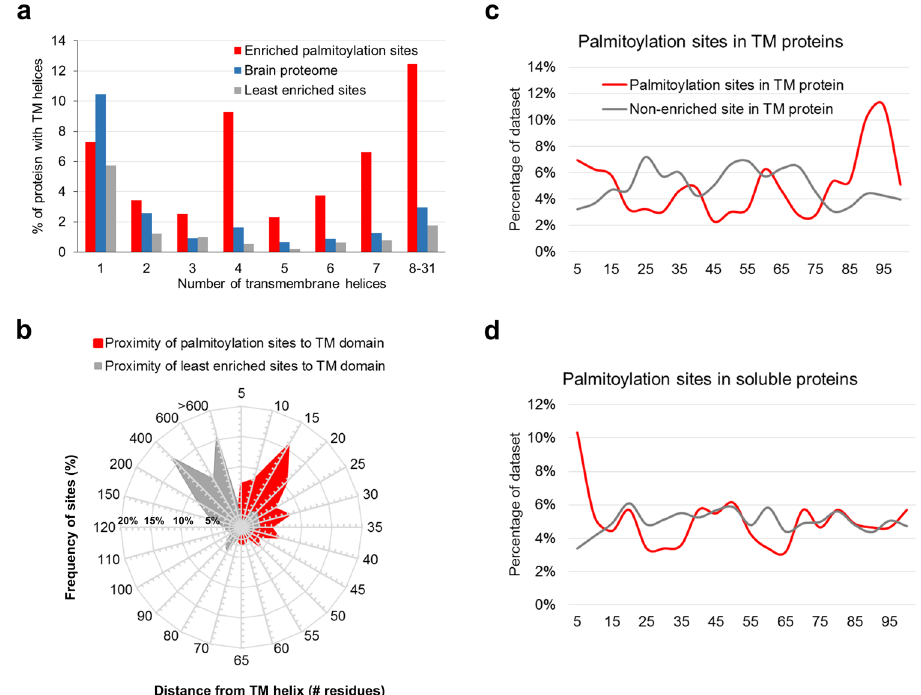
Figure 3. Occurrence and topology of palmitoylation sites in transmembrane proteins. ( a ) The frequency of transmembrane helices in proteins for which we identified palmitoylation sites was compared to that occurring in the set of “least enriched” sites identified by the ssABE method. In general, palmitoylation sites occurred more frequently in multi-membrane spanning proteins with striking enrichment for proteins with 4, 7 and more than 8 transmembrane helices. ( b ) The proximity of palmitoylation sites to transmembrane helices was compared to an equivalent number of the “least enriched” sites identified by the ssABE method. Two distinct distributions are observed with palmitoylation sites most frequently located approximately 15 residues from a transmembrane helix and the “least enriched” sites being most frequent over 400 residues from a transmembrane helix. The position of palmitoylation sites and the set of “least enriched” sites identified by ssABE relative to protein length was compared for transmembrane proteins in ( c ) and soluble proteins in ( d ). Relative positions are expressed as a percentage of the protein length in residues. Palmitoylation sites in transmembrane proteins are most frequently located in the first 10% of proteins (N-terminus) or in the last 20% (C-terminus). Palmitoylated soluble proteins exhibit a different profile with the most frequent position of palmitoylation sites located in the first 10% of the proteins (extreme N-terminus) but without the C-terminal distribution spike observed for palmitoylated transmembrane